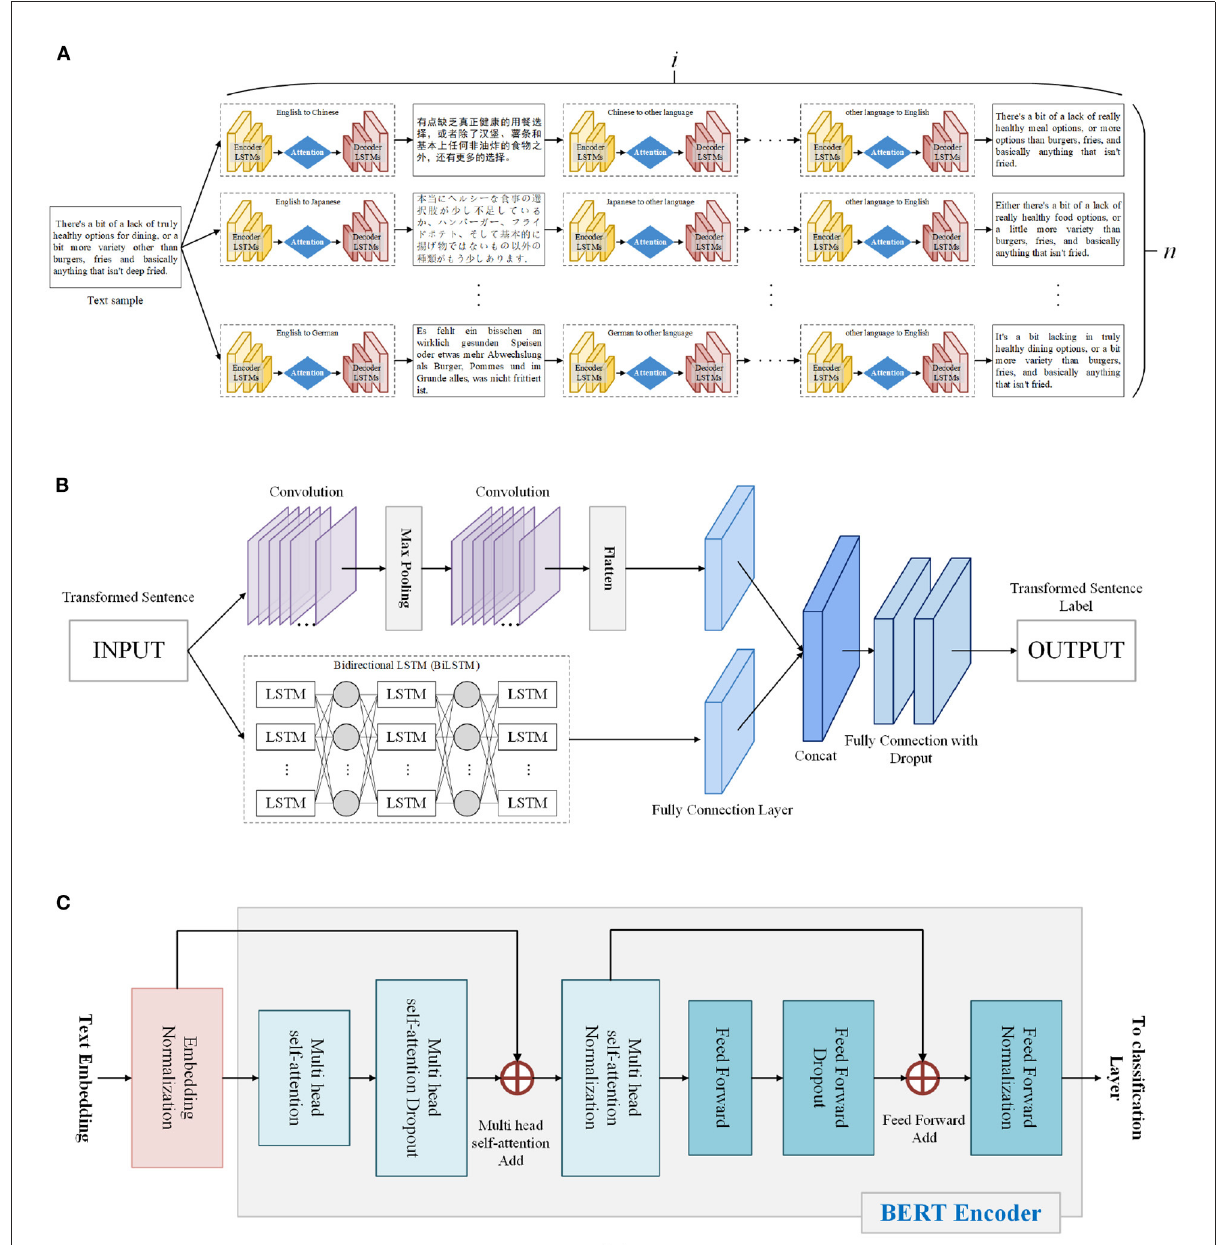
FIGURE2 Structure of (A) SG, (B) SD, and (C)